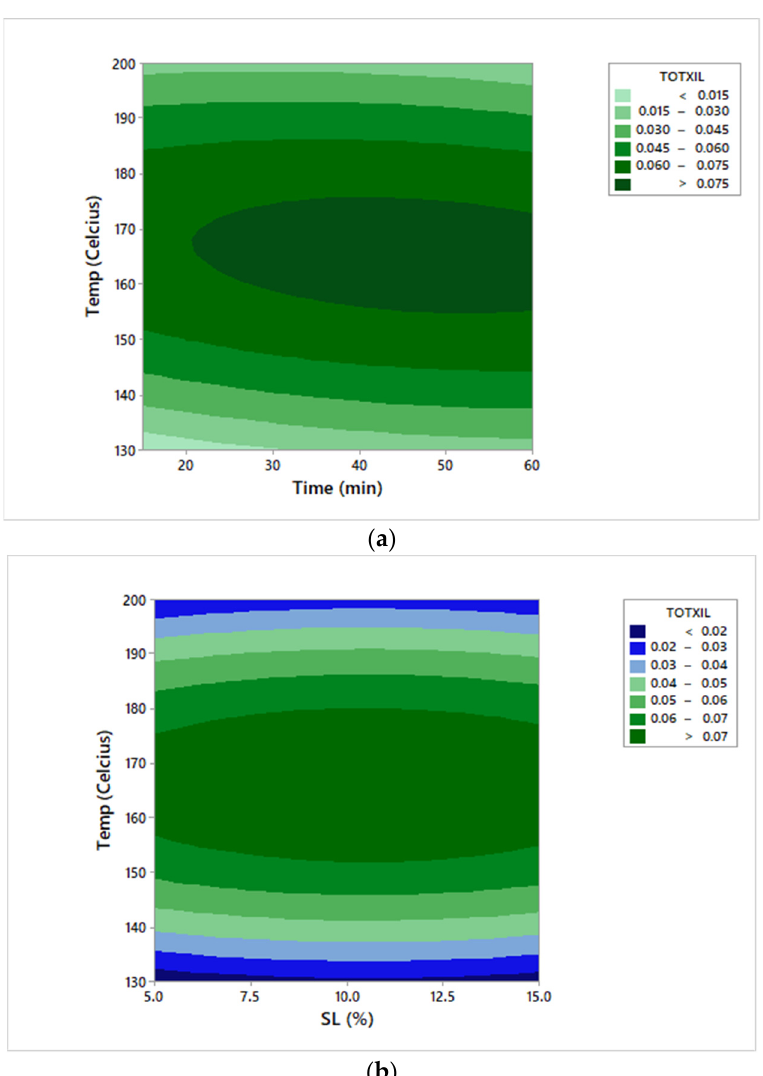
Figure 5. Contour plot for maximum total xylose recovery on hydrolysate of a) solid pretreated OPEFB and b) liquor pretreated OPEFB.